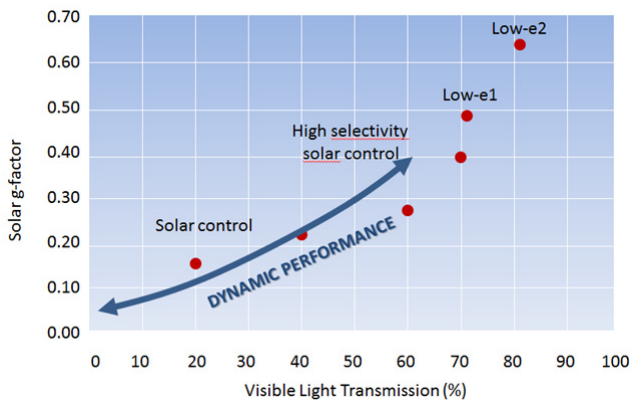
Fig. 2 Graph of visible light transmission versus solar g factor which demonstrates the heat gain and light transmission range of EC glass compared with examples of standard static glass.